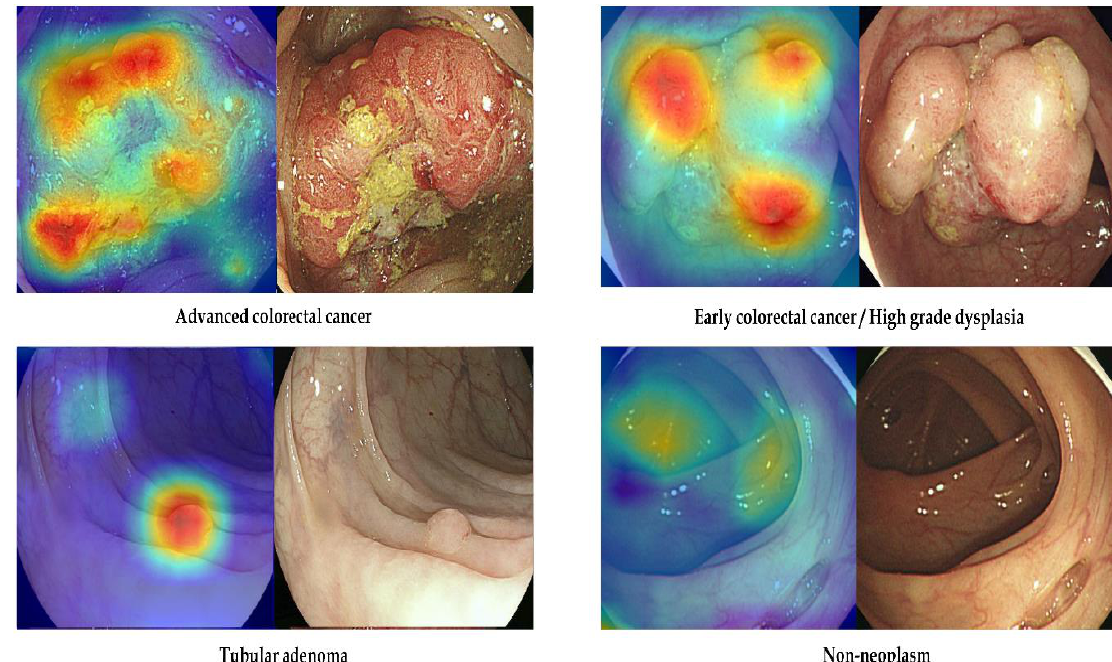
Figure 3. Representative examples of correctly classified lesions in the internal-test datasets. Left: gradient-weighted class activation mapping image. Right: white-light endoscopic image.